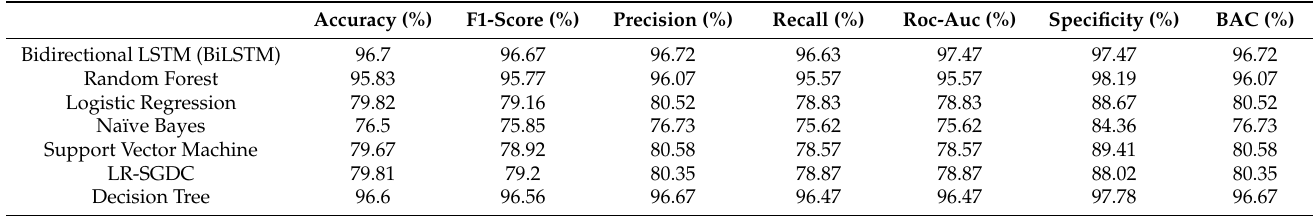
Table 6. The performance measure of various classifiers of the first dataset.